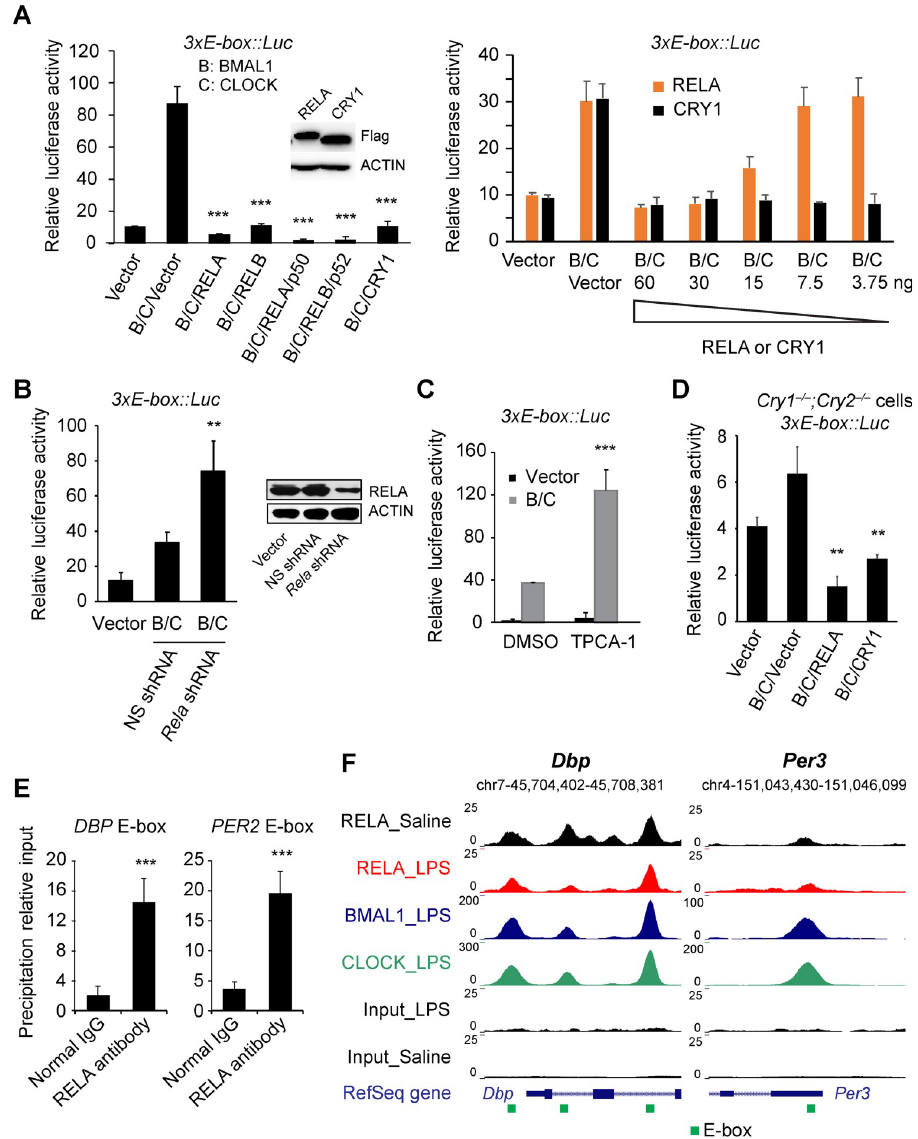
Fig 4. NF- κ B represses E-box mediated transcriptional activity of BMAL1/CLOCK. (A) Steady-state luciferase reporter assay in transiently transfected 293T cells. In the 3xE-box :: Luc reporters, Luc expression is controlled by tandem E-box repeats. RELA and RELB repressed the transcriptional activity of BMAL1/CLOCK at the 3xE-box :: Luc reporter (left). While both RELA and CRY1 dose dependently repressed the reporter, CRY1 repression is more potent. Flag-tagged RELA and CRY1 were expressed to similar levels (Western blot inset). (B-C) RNAi knockdown of endogenous RELA (Western blot inset in B) or inhibition of IKK2 by TPCA-1 (20 μ M) (C) relieved the repression of BMAL1/CLOCK by RELA. (D) Steady-state luciferase reporter assay in transiently transfected Cry1 –/– ;Cry2 –/ – fibroblasts using the 3xE-box :: Luc reporter. RELA was able to repress E-box transcription in the absence of the endogenous CRY. (E) RELA associates with the E-box cis-element of clock genes PER2 and DBP in U2OS cells. Chromatin immunoprecipitation (ChIP) and Q-PCR to detect binding of endogenous RELA to the promoters of PER2 and DBP at the E-box. ChIP was performed with an anti-RELA or normal IgG antibody. Representative data from three independent experiments are shown. Data are mean ± standard deviation (n = 3). (F) Representative UCSC genome browser images of RELA, BMAL1, and CLOCK ChIP-seq tracks at the Dbp and Per3 genes. Normalized tag counts are indicated on the Y-axis. Green square, E-box. ChIP-seq analysis revealed overlapping binding of BMAL1, CLOCK and RELA at the E-boxes of Dbp and Per3 . Motif analysis did not find NF- κ B-RE in these binding peaks, suggesting indirect binding of NF- κ B to the E-box. �� p < 0.01. ��� p <